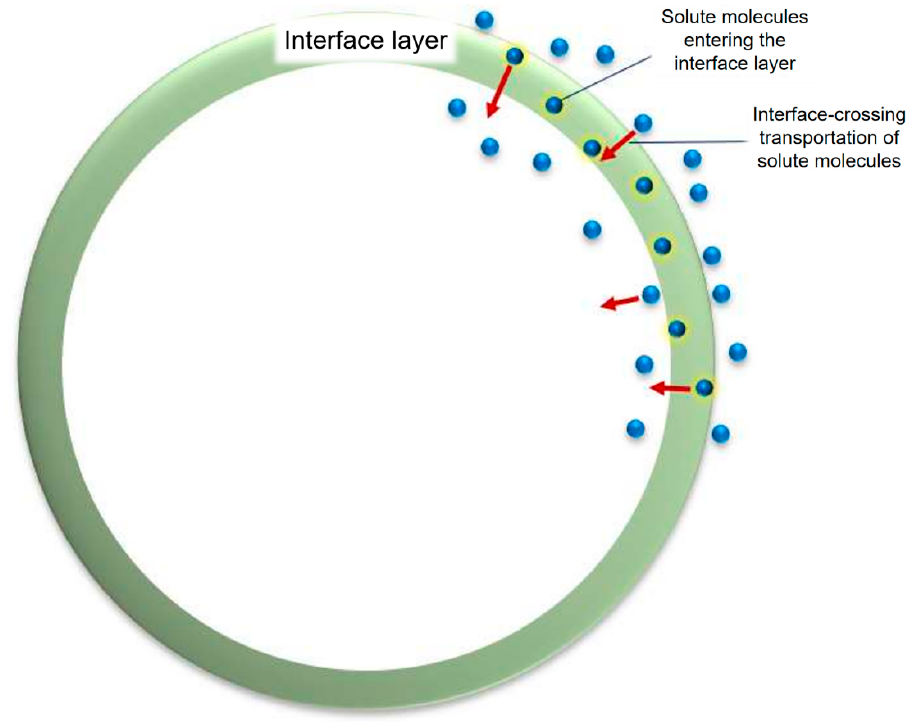
Figure 8. Schematic diagram of the generation mechanism of the interfacial relaxation force [79].